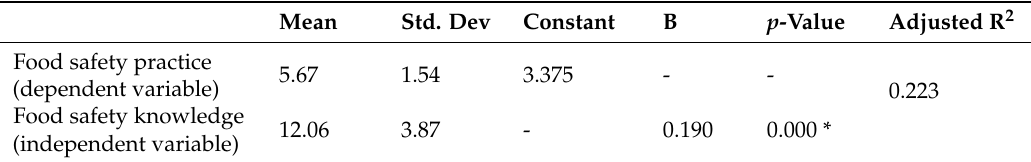
Table 10. Influence of food safety knowledge on food safety practice using a linear regression model. Mean Std. Dev